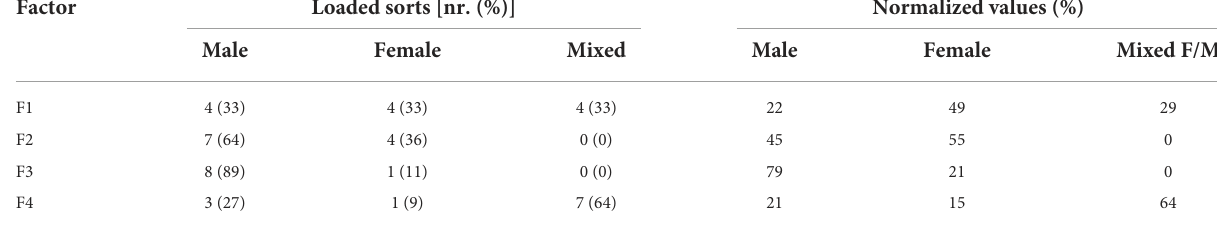
TABLE 8 Gender distribution across the four factors. Factor Loaded sorts [nr. (%)] Normalized values (%) Male Female Mixed